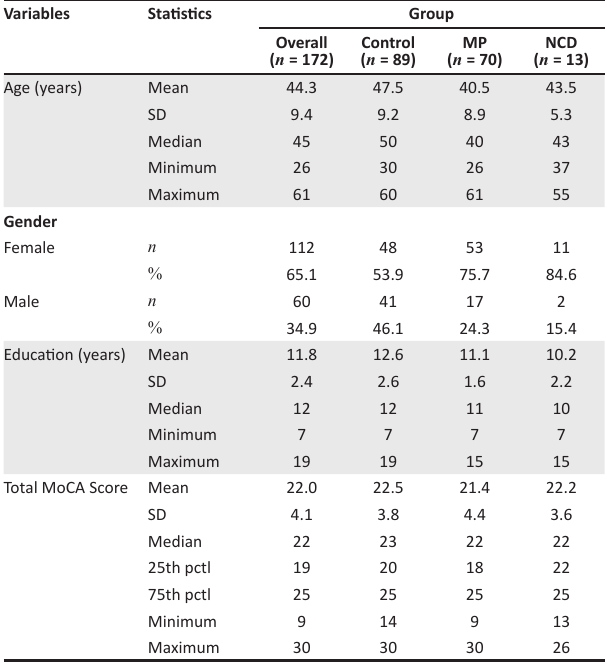
Source : The control group data was collected by the second author (A.F.C.) for the purpose of her PhD study. Ferreira-Correia, A. (2019). The neurocognitive profile of Huntington disease-Like 2: A comparison with Huntington disease and healthy controls . PhD thesis, University of the Witwatersrand NCD, neurocognitive disorders; SD, standard deviation; pctl,